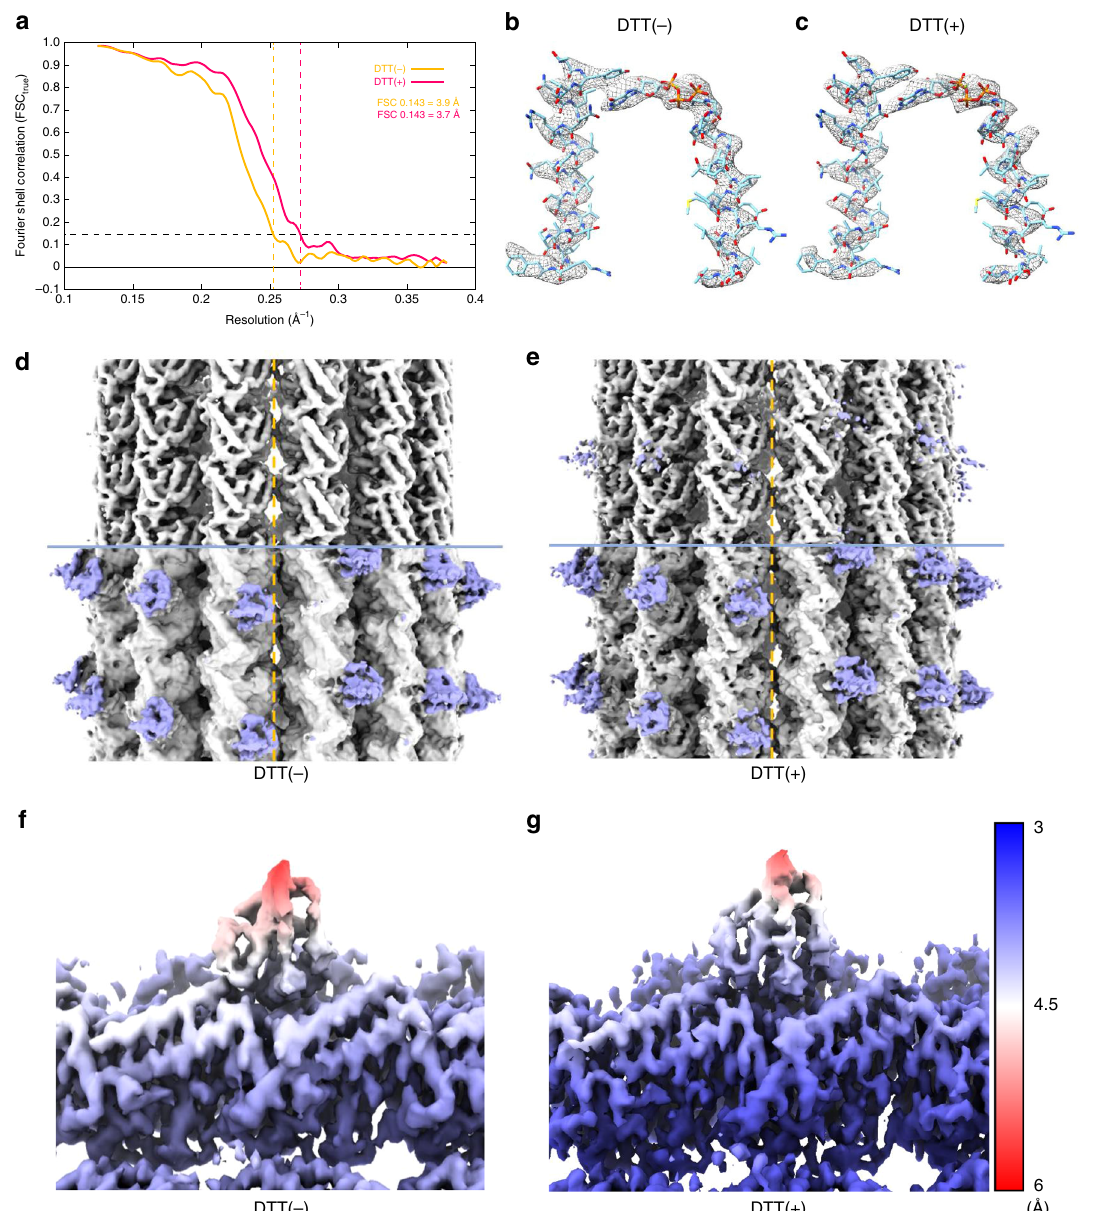
Fig. 3 Cryo-EM single-particle reconstruction of the MTBD-High-MT complex in the absence ( − ) and presence ( + ) of DTT. a Fourier Shell Correlation (FSC true ) curves for the structures of MTBD-High-MT complex for both ± DTT conditions, using a FSC 0.143 criterion. b , c Cryo-EM density segmented from the post-processed maps (using relion_postprocess , fi ltered to local resolution) of MTBD-High-MT complex and fi tted atomic model of H4, H7, GMPCPP, and Mg 2 + of α -tubulin (PDB code: 1JFF) for ( b ) DTT( − ) and ( c ) DTT( + ) conditions. d , e C1 reconstruction of MTBD-High-MT complex for ( d ) DTT( − ) and ( e ) DTT( + ) conditions ( fi ltered to 4.44 Å and 4.33 Å, respectively). The broken line indicates the location of the seam. The upper half is displayed at high threshold to show secondary structures in MTs. The lower half is displayed at lower threshold to show the MTBD structure. f , g Density of MTBD-High-MT complex colored and fi ltered according to local resolution determined using relion_postprocess for ( f ) DTT( − ) and ( g ) DTT( + )